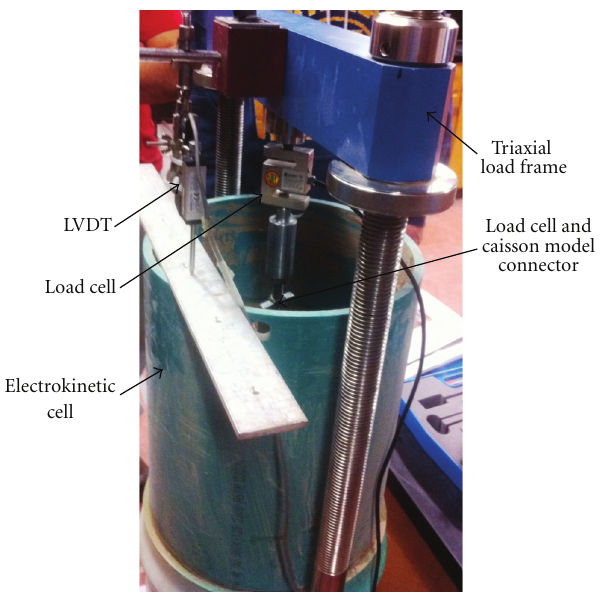
Figure 6: Electrokinetic cell during axial load testing for the model